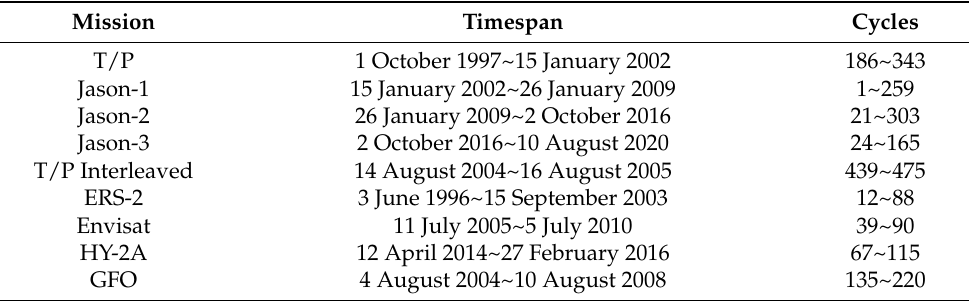
Table 1. Parameter information of the altimetry satellite data used in this study.